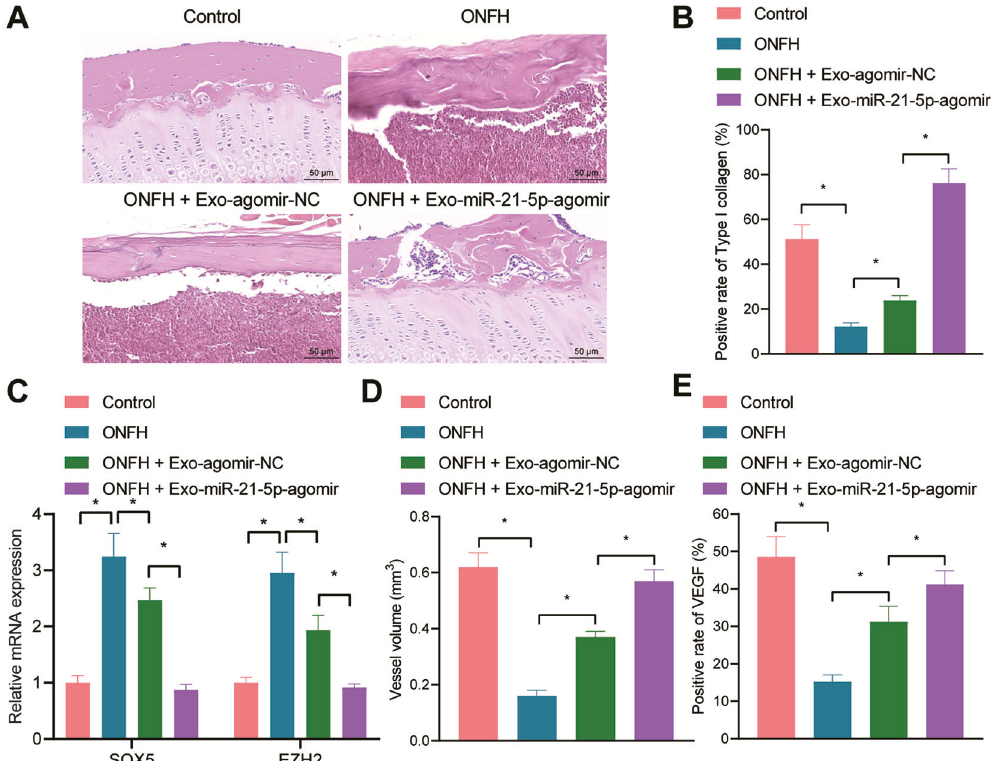
Fig. 5 hucMSC-Exos augment angiogenesis and osteogenesis in vivo by delivering miR-21-5p. A H&E staining of femoral head tissues in rats; B immunohistochemistry of collagen I expression in femoral head tissues in rats; C SOX5 and EZH2 mRNA expression in rat femoral head tissues determined by RT-qPCR; D angiography of the vascular system in the femoral head tissues in rats by micro fi ber perfusion; E VEGF expression in the femoral head tissues in rats determined with immunohistochemistry. n = 6. * p <